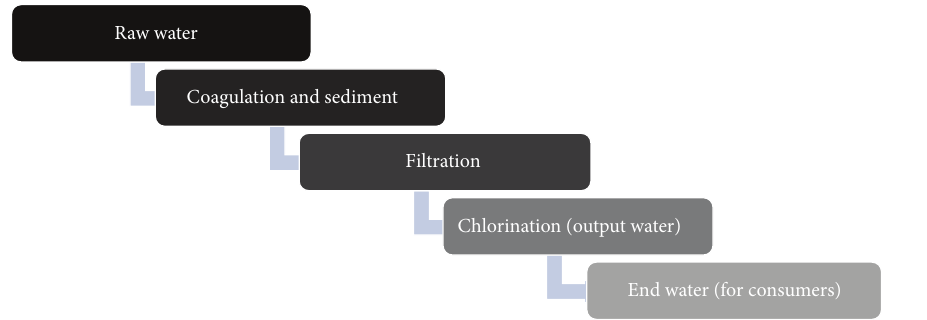
Figure 1: The conventional treatment process for tap water.